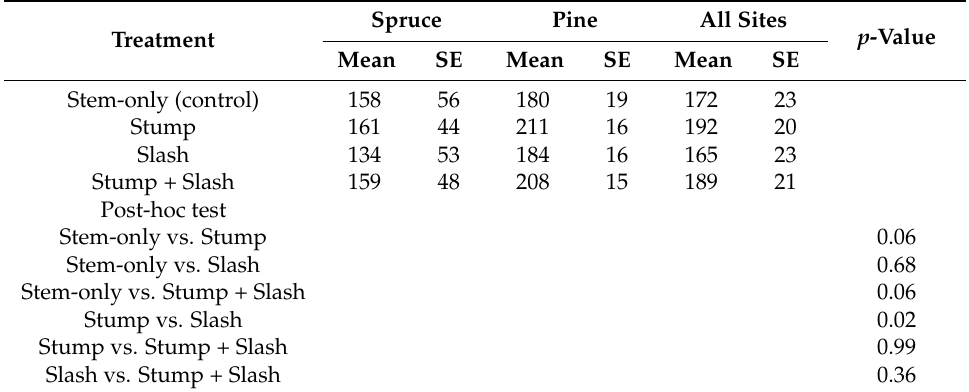
Table 2. Stand volume production (m 3 ha − 1 ) during 31–34 years for stands planted after additional harvest of stumps, slash, both stumps and slash relative to the control treatment where only the stem wood was harvested leaving stumps and slash